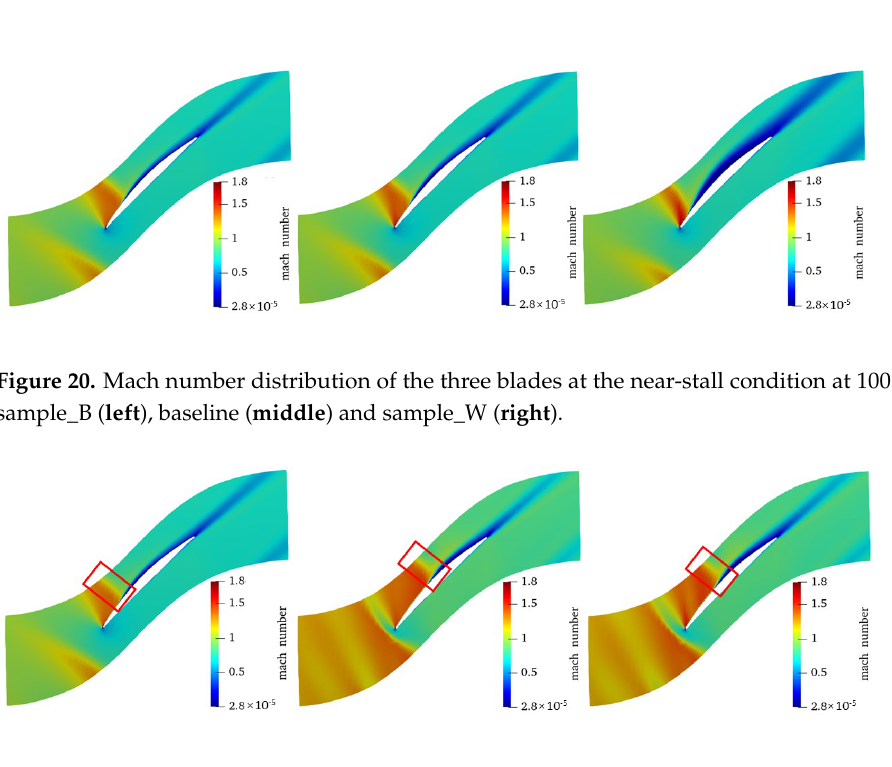
Figure 21. Mach number distribution of the three blades at the near-stall condition at 120% speed: sample_B ( left ), baseline ( middle ) and sample_W ( right ).